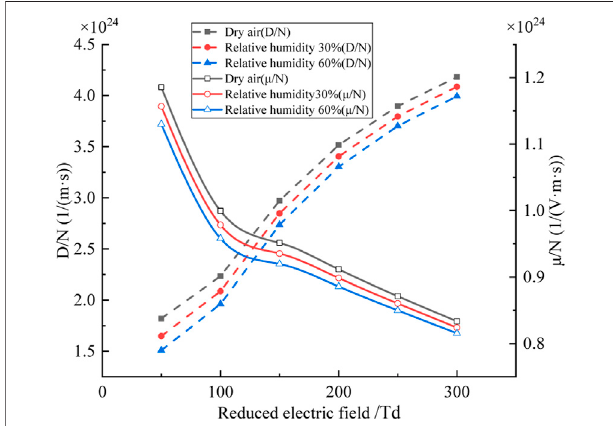
FIGURE 3 | The variation of electron transport parameters with reduced fi eld strength under different